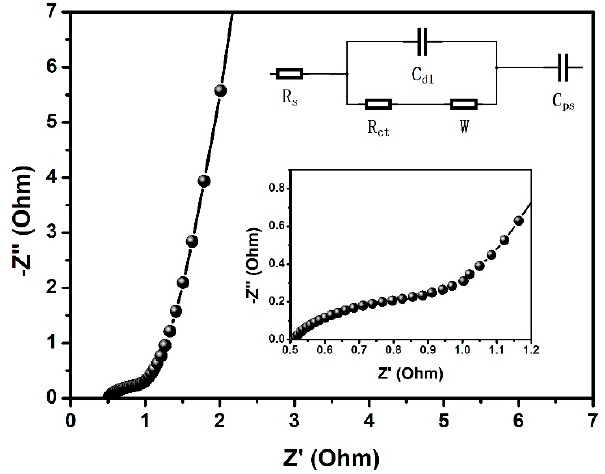
Figure 6. Electrochemical impedance spectrum (EIS) plot of the Co 3 O 4 electrode over a frequency range from 100 mHz to 100 kHz. The insets show the equivalent circuit and an enlarged view of the high frequency region.